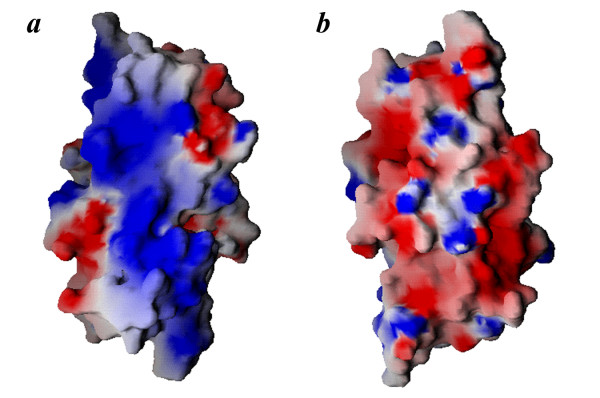
The electrostatic surface potential of the Vc-HlyU dimer with blue and red regions indicating positive and negative electrostatic regions, respectively. (a) The DNA-binding surface indicates the highly basic nature of the DNA-binding domains in the two subunits. (b) The molecule is rotated 180° around the long axis showing the opposite surface of DNA-binding region which is predominantly negatively charged and highly acidic.